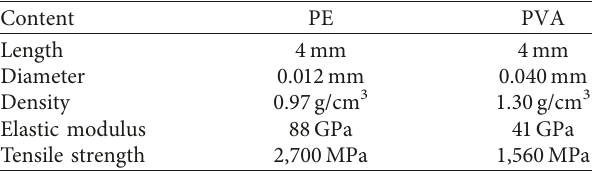
Table 5: Cases and test